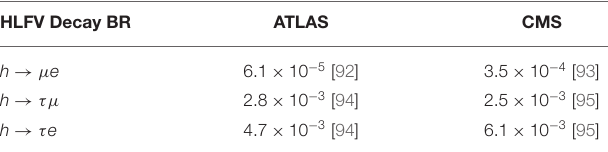
TABLE 2 | Current experimental bounds and future sensitivities for several LFV observables of interest. LFV process